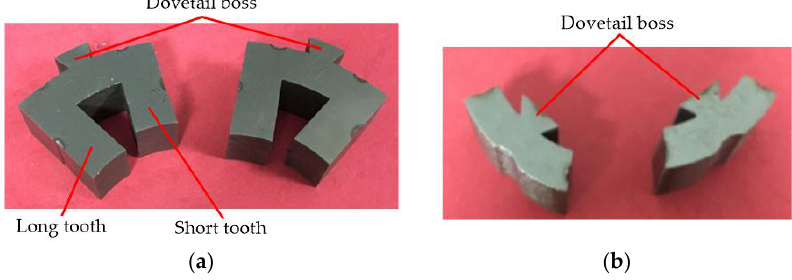
Figure 15. Iron core units: ( a ) The primary; ( b ) The secondary.